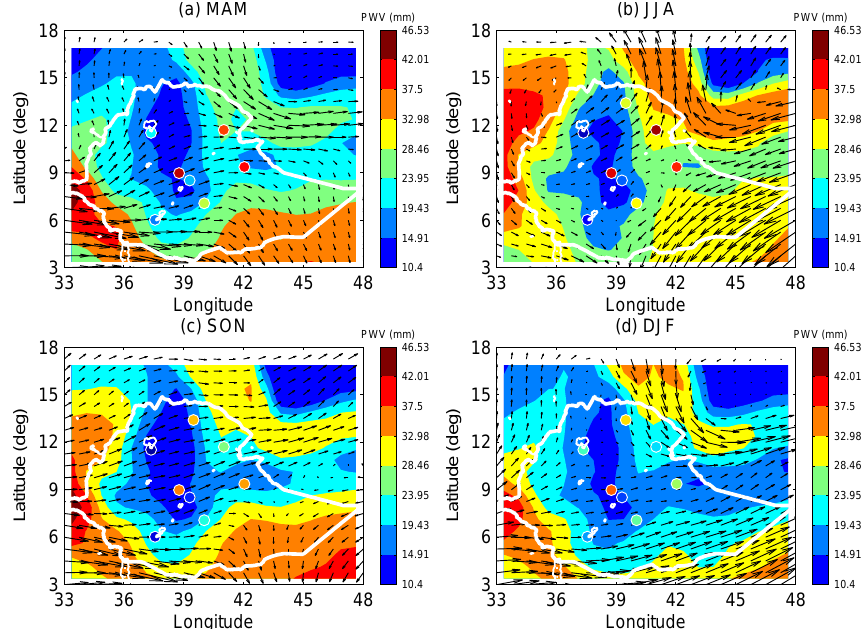
Figure 13. The ERA-Interim PWV (colour contours), and vertically integrated (to 500hPa) moisture flux (vectors) over the study region. The circle, filled with different colours according to ERA-Interim PWV bias with respect to GPS PWV (i.e. from highest negative bias ( − 6 . 9mm) in blue to highest positive bias in dark red (6.0mm) for all seasons on the same scale; See also Fig. 11), represents the eight GPS sites and the white solid line represents the boundary of Ethiopia.